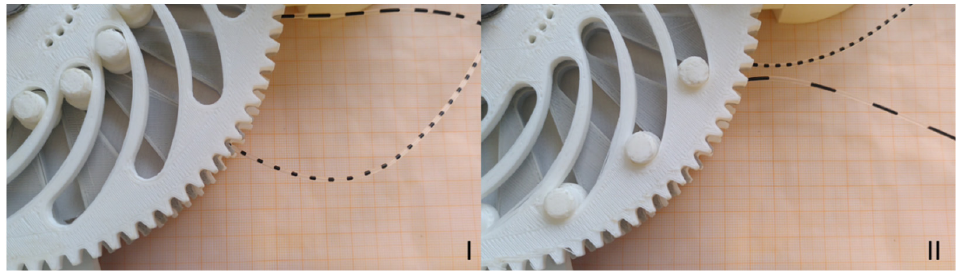
Figure 20 . Stationary phase ratios and slug lengths before ( I ) and after ( II ) switching.